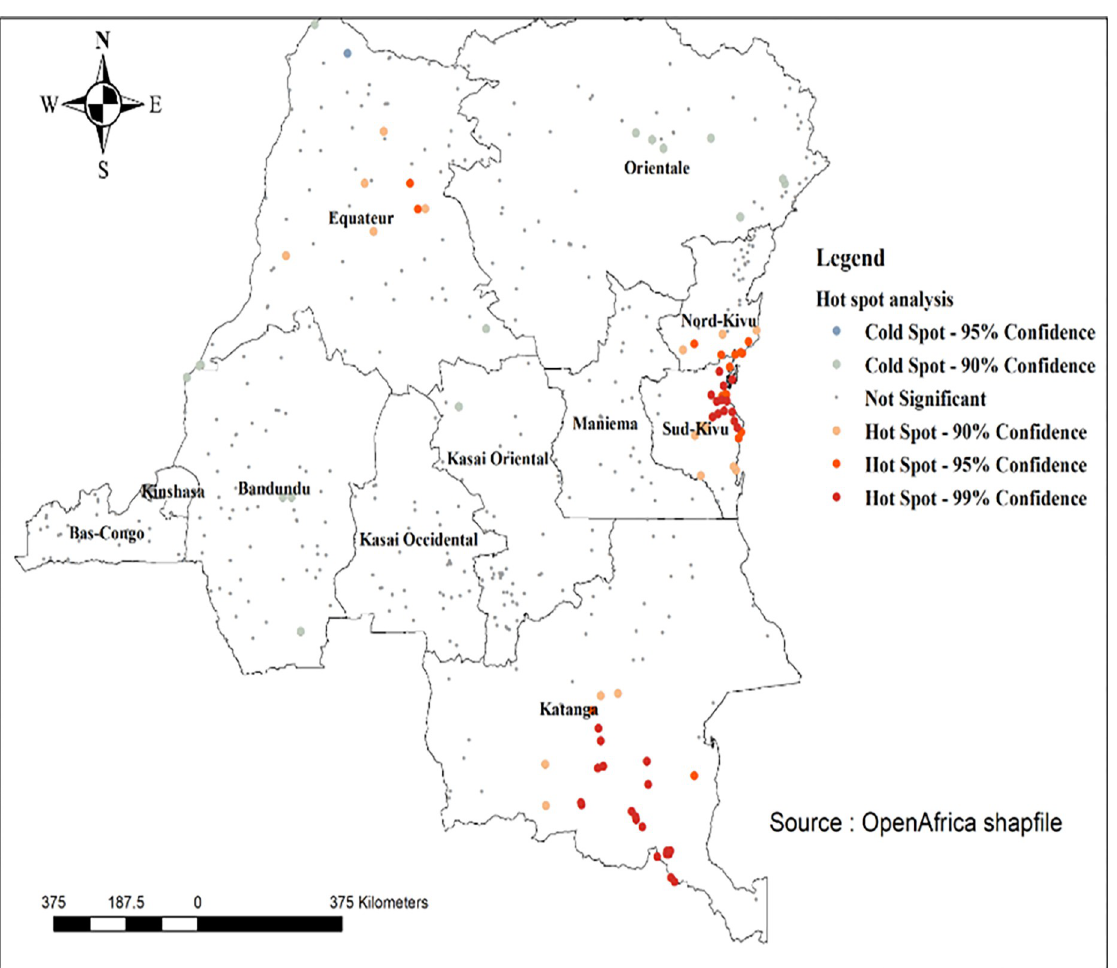
Fig 6. Hot spot results of high-risk fertility behaviours among married women in the Democratic Republic of the Congo.